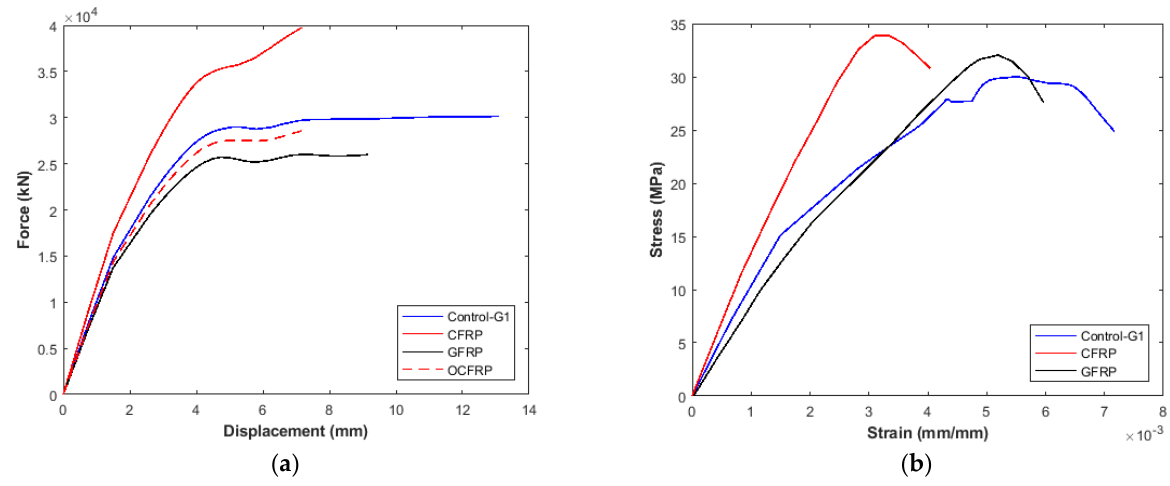
Figure 13. Group G ( a ) Load-Displacement diagram ( b ) Stress-Strain Diagram .